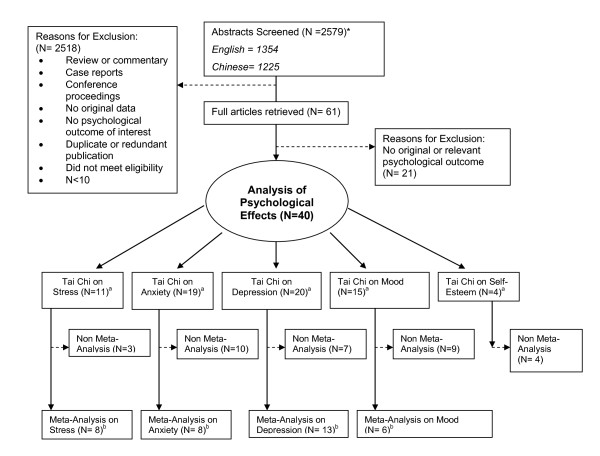
Flow diagram of selection of articles for inclusion* *N = number of studies. aThese numbers add up to more than 40 because most studies assessed more than one psychological well-being state. bThese numbers add up to more than 21 because most studies assessed more than one psychological well-being state.